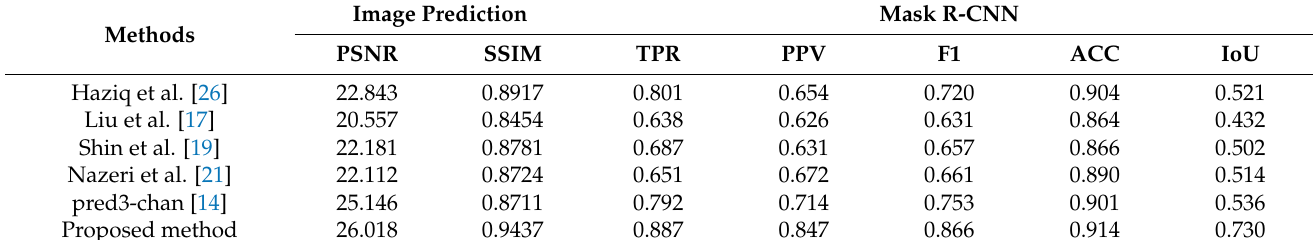
Table 14. Comparisons of accuracies of image prediction and human segmentation by the proposed method with those of the state-of-the-art methods.